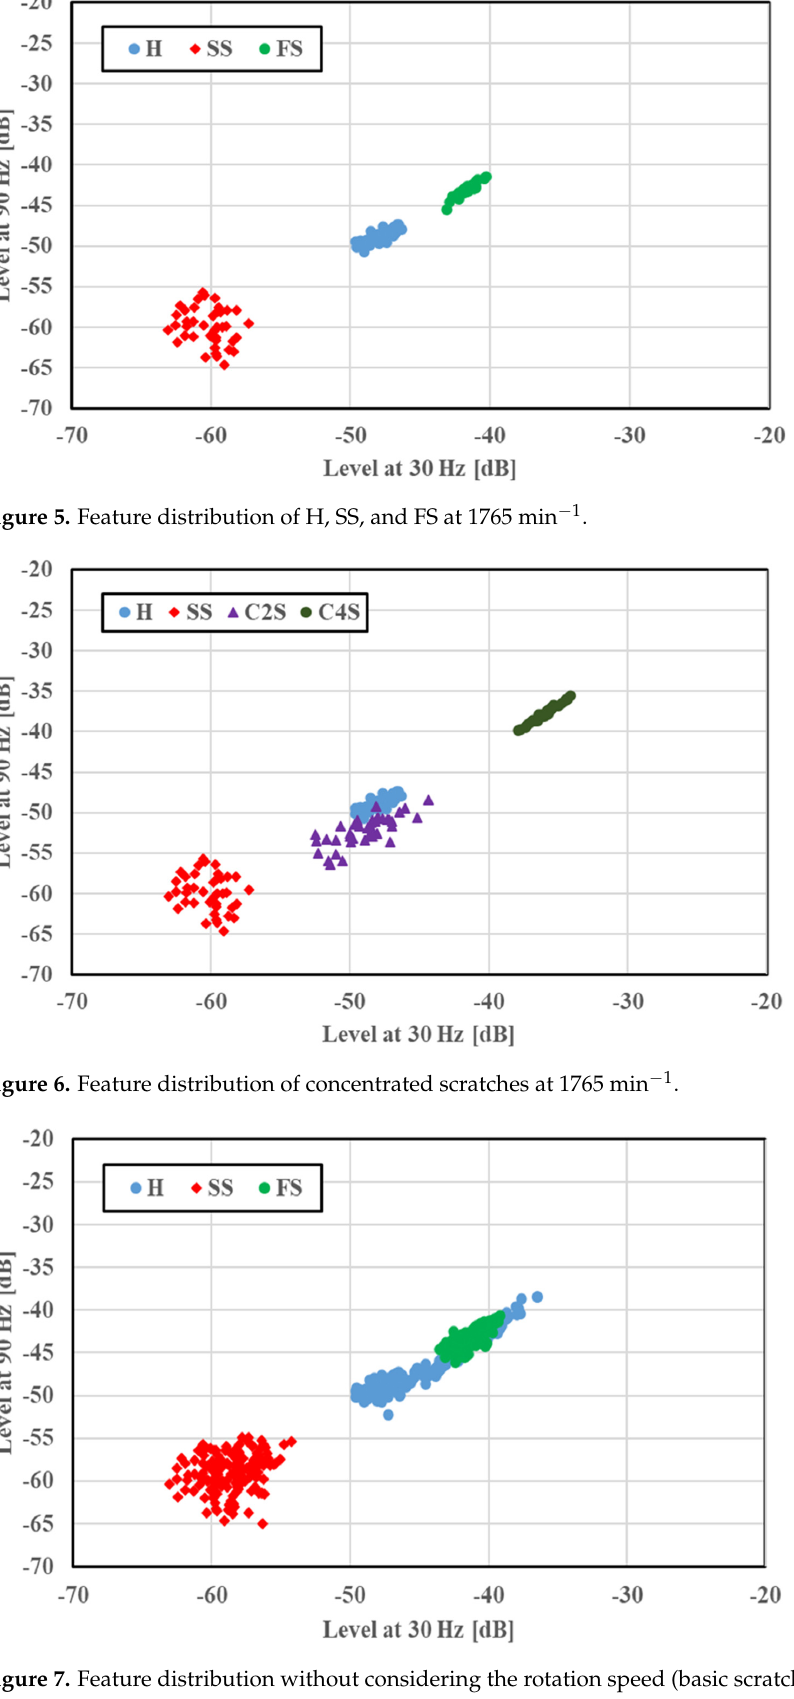
Figure 8. Feature distribution without considering the rotation speed (concentrated scratch). 4. Procedures and Results of Diagnosis This section explains the diagnostic results of the basic scratch faults and scratch traceability. 4.1. Diagnosis of Basic Scratch Faults Diagnosis was performed on three types of bearing conditions (H, SS, and FS) with- out considering the rotation speed of the induction motor; the features obtained at four rotation speeds were merged. The datasets of the 30 and 90 Hz frequency components were divided into two groups randomly in a 70:30 ratio. Seventy percent of the data for each bearing condition (336 in total) was used for training, and the remaining 30% (144 in total) was used for diagnosis. Since DL follows a stack-flow method of diagnosis, H, SS, and FS took stack values of 0, 1, and 2, respectively.